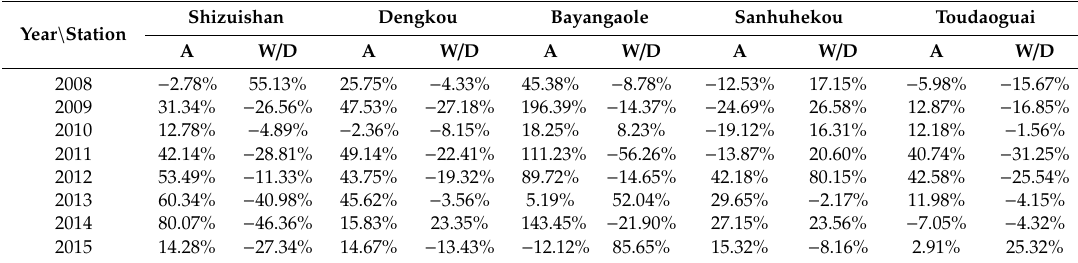
Table 4. Changes in the channel geometrical parameters at the five stations after each summer flooding